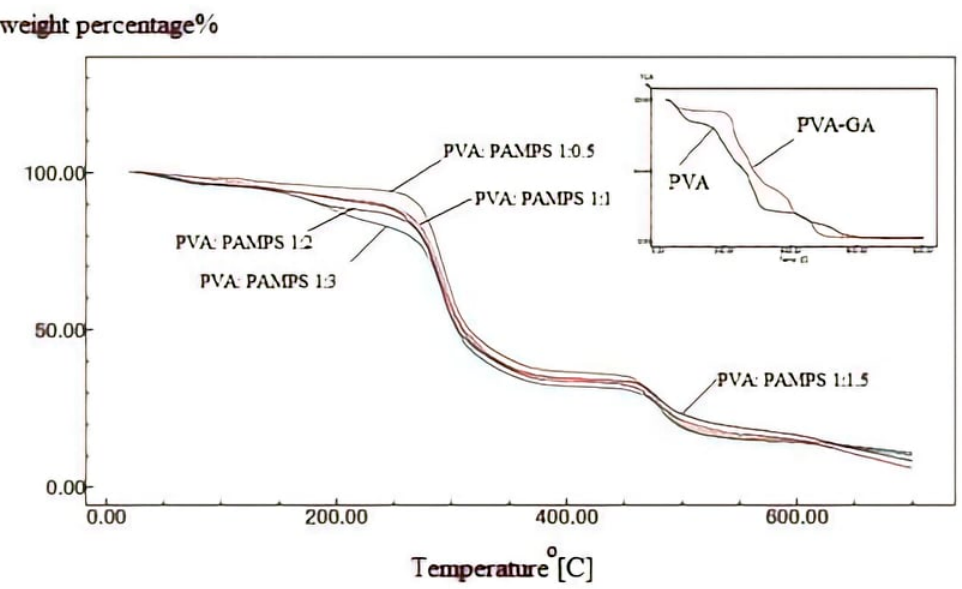
Figure 3. TGA Thermograms of non-cross-linked PVA, GA-cross-linked PVA, and PVA/PAMPS blend-based membranes.